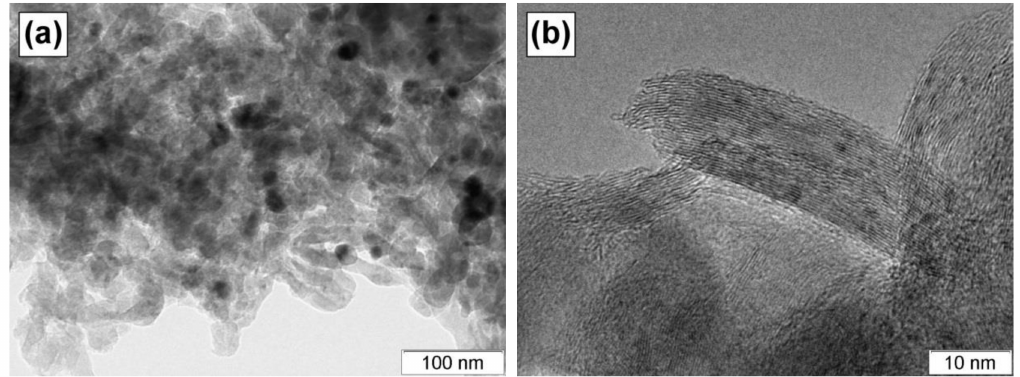
Figure 7. TEM images of the carbon product obtained via CCVD of 1,2–dichloroethane over the Ni-Mo-Mg-O catalyst at various magnifications: ( a ) × 50,000 and ( b ) ×